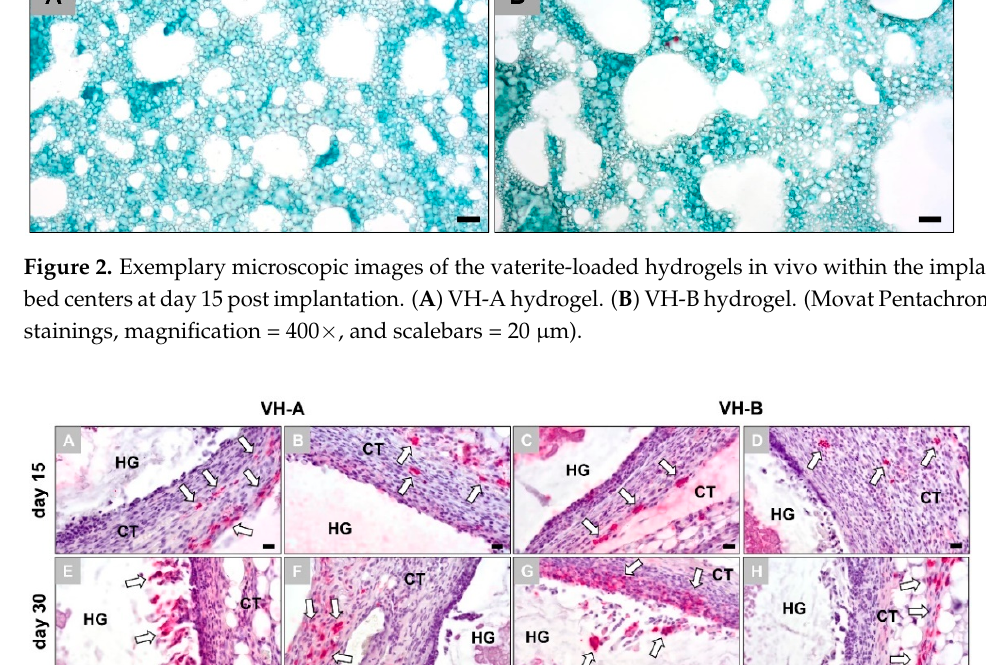
Figure 2. Exemplary microscopic images of the vaterite-loaded hydrogels in vivo within the implant bed centers at day 15 post implantation. ( A ) VH-A hydrogel. ( B ) VH-B hydrogel. (Movat Penta- chrome stainings, magnification = 400 × and scalebars = 20 µm).